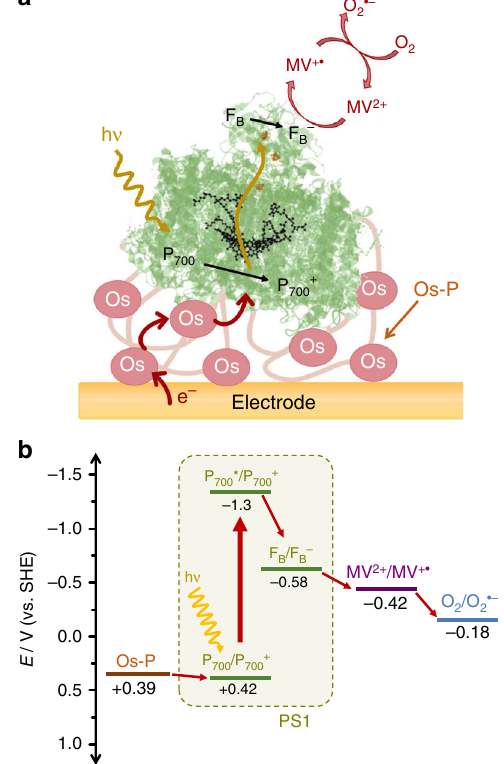
Fig. 1 Overview of the charge transfer pathway in the PS1/Os-complex- modi fi ed redox polymer-based photocathode. a Schematic representation of the PS1 photocathode. The redox polymer acts simultaneously as immobilization matrix and as a mediator for the reduction of the photo- oxidized P 700 + site at PS1. MV 2 + is used as electron scavenger in solution for the uptake of electrons from the reduced Fe-S cluster F B − at the stromal side of PS1. The ef fi cient reduction of O 2 in solution by the generated MV + (cid:129) allows fast regeneration of MV 2 + in solution with the concomitant generation of superoxide radicals. (P 700 *: photo-excited P 700 special chlorophyll pair). b Energy levels for the terminal cofactors involved in the electron-transfer sequence of PS1 and formal potentials of the Os-complex-modi fi ed polymer (Os-P), methyl viologen, and the O 2 /O 2 (cid:129) − couple at pH 7.0